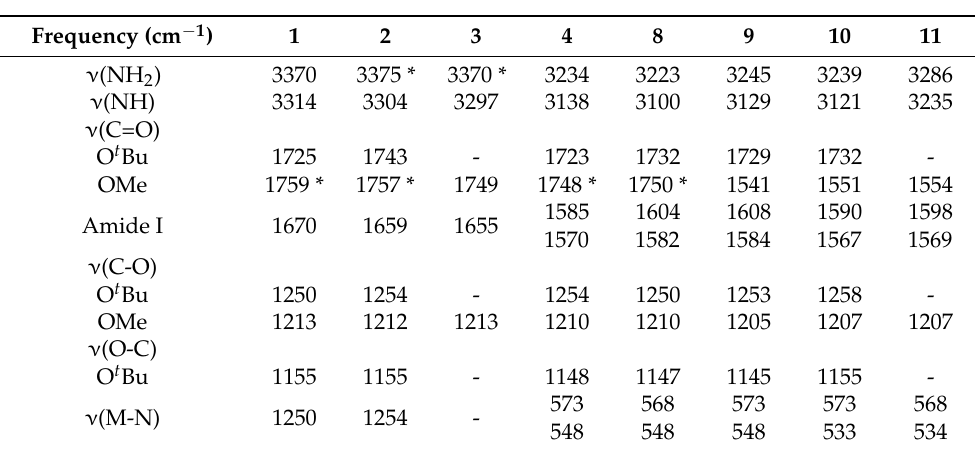
Table 5. Summary of infrared data for 1 – 4 , 8–11 .